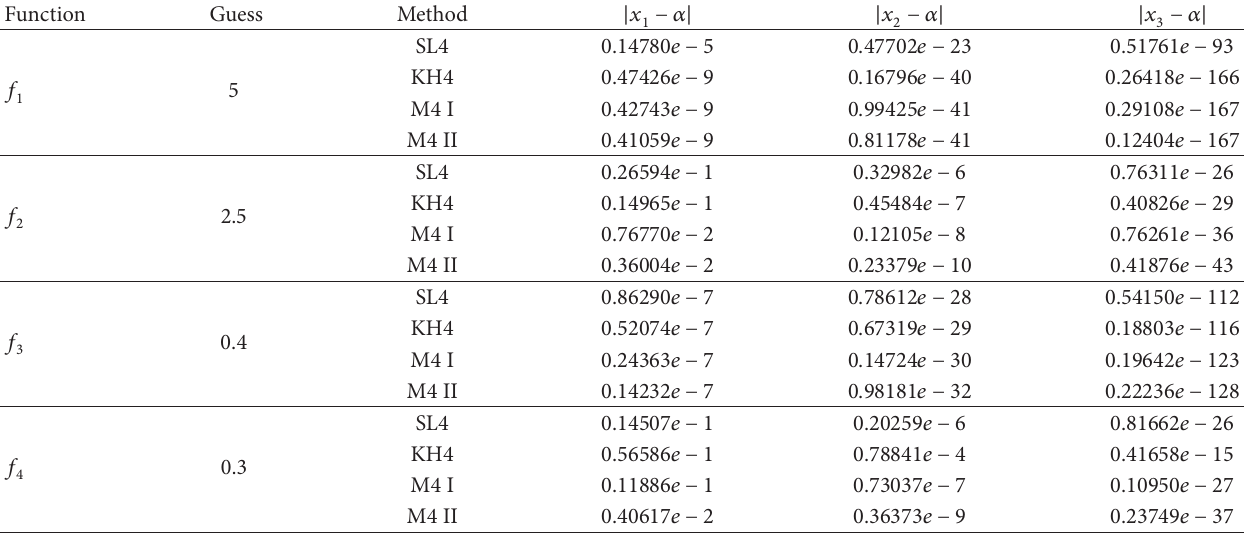
Table 3: Comparison of the absolute error occurring in the estimates of the exact root.